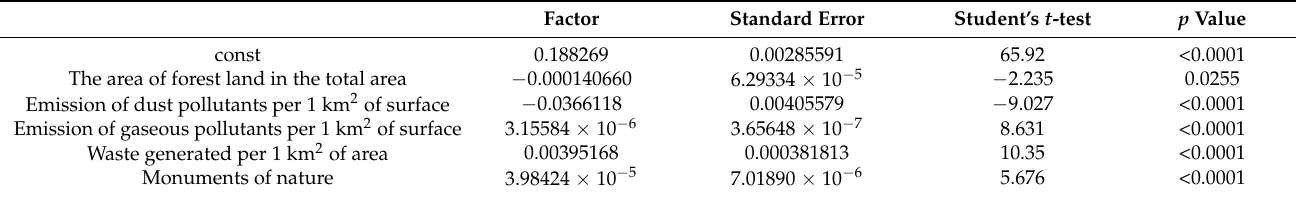
Table 6. Results of the regression analysis between the development measure and the variables of the natural environment and ecology of counties in Poland (in